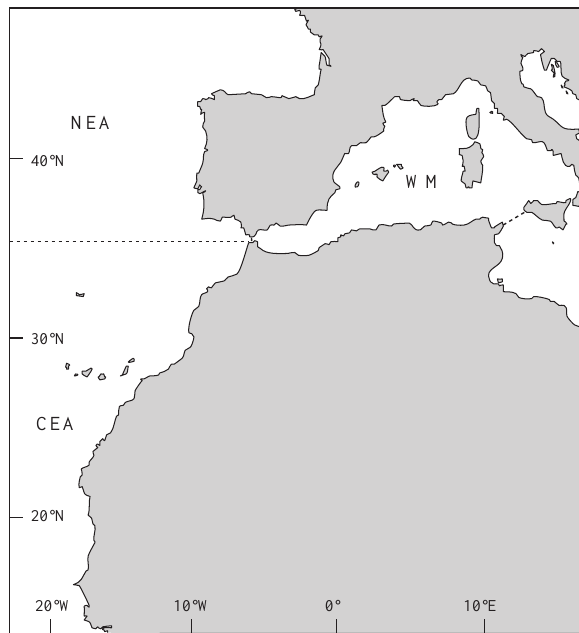
Fig. 2. – Map showing the areas where the otoliths were collected: North Eastern Atlantic (NEA), Central Eastern Atlantic (CEA) and Western Mediterranean